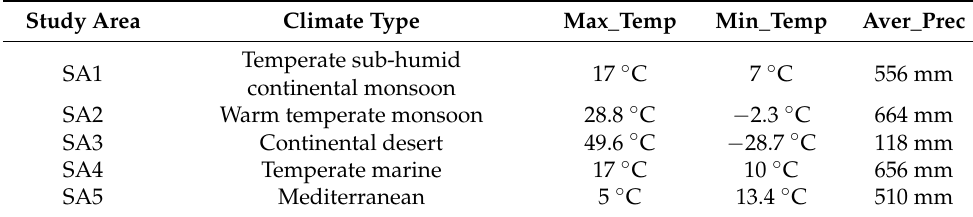
Table 1. Specific information on the five study areas.